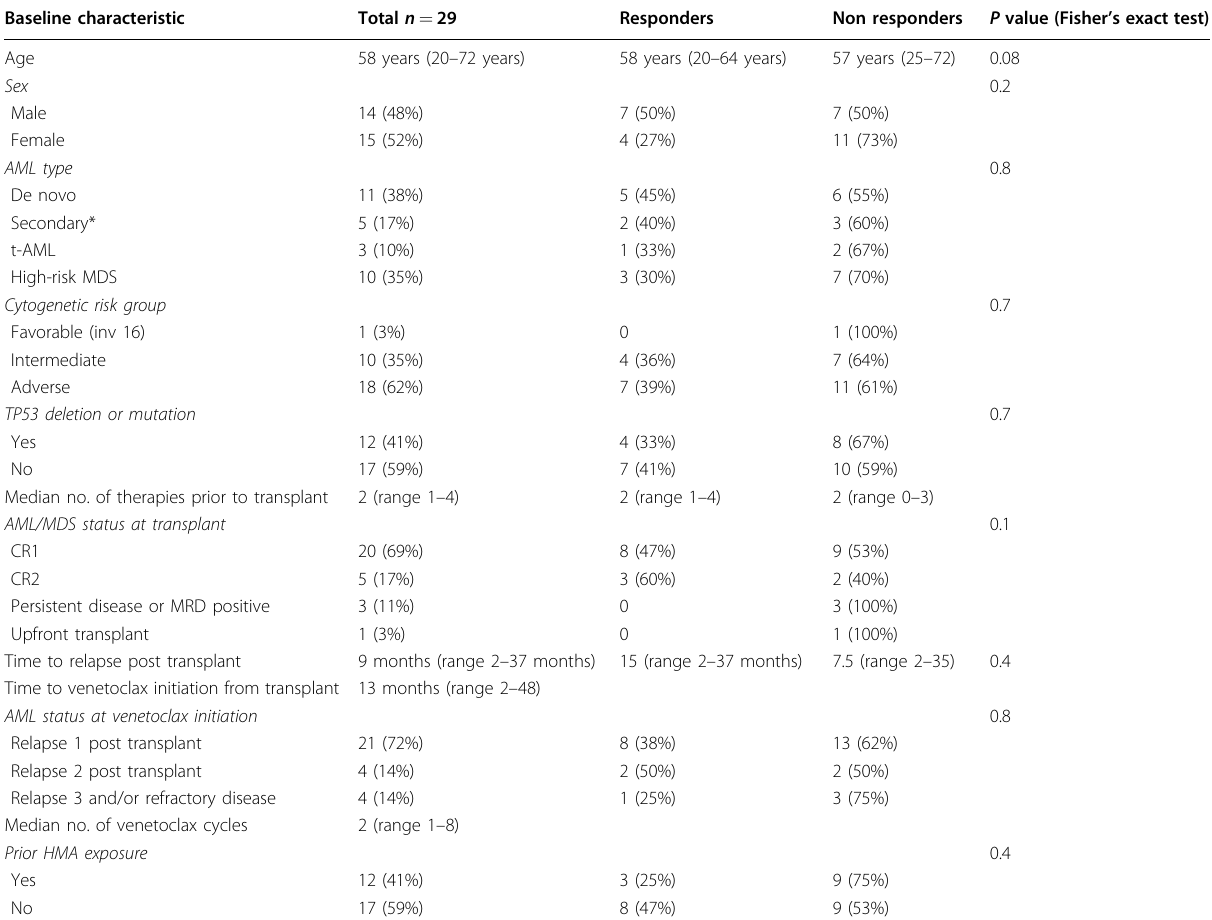
Table 1 Baseline characteristics and response in patients salvaged with